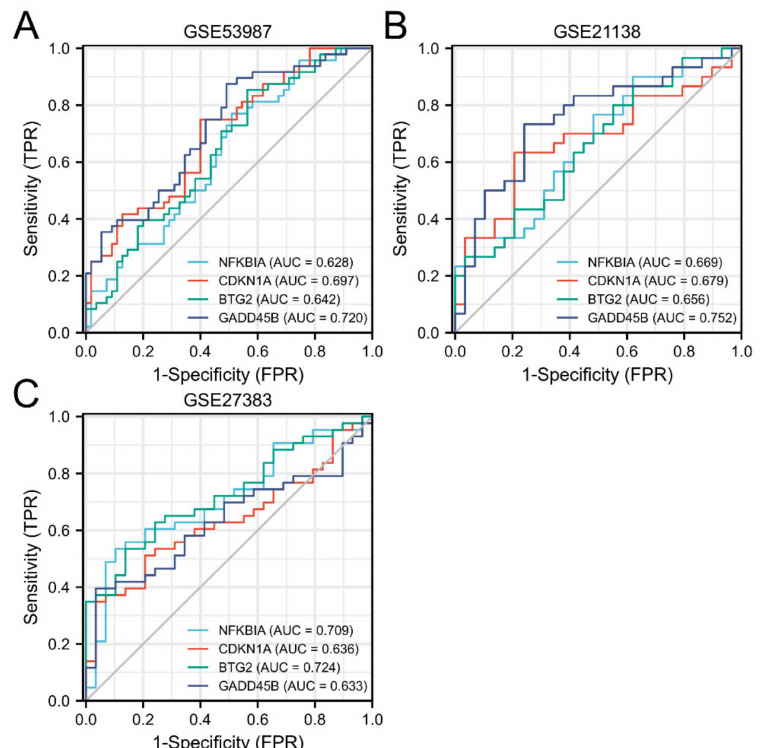
Figure 13. Diagnostic evaluation of 4 hub genes from three datasets. ( A ) GSE53987; ( B ) GSE21138; ( C ) GSE27383.